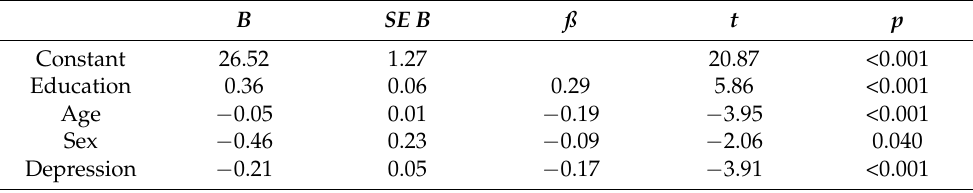
Table 2. Linear regression analysis for German sample on cognition measured with MoCA ( n = 417).